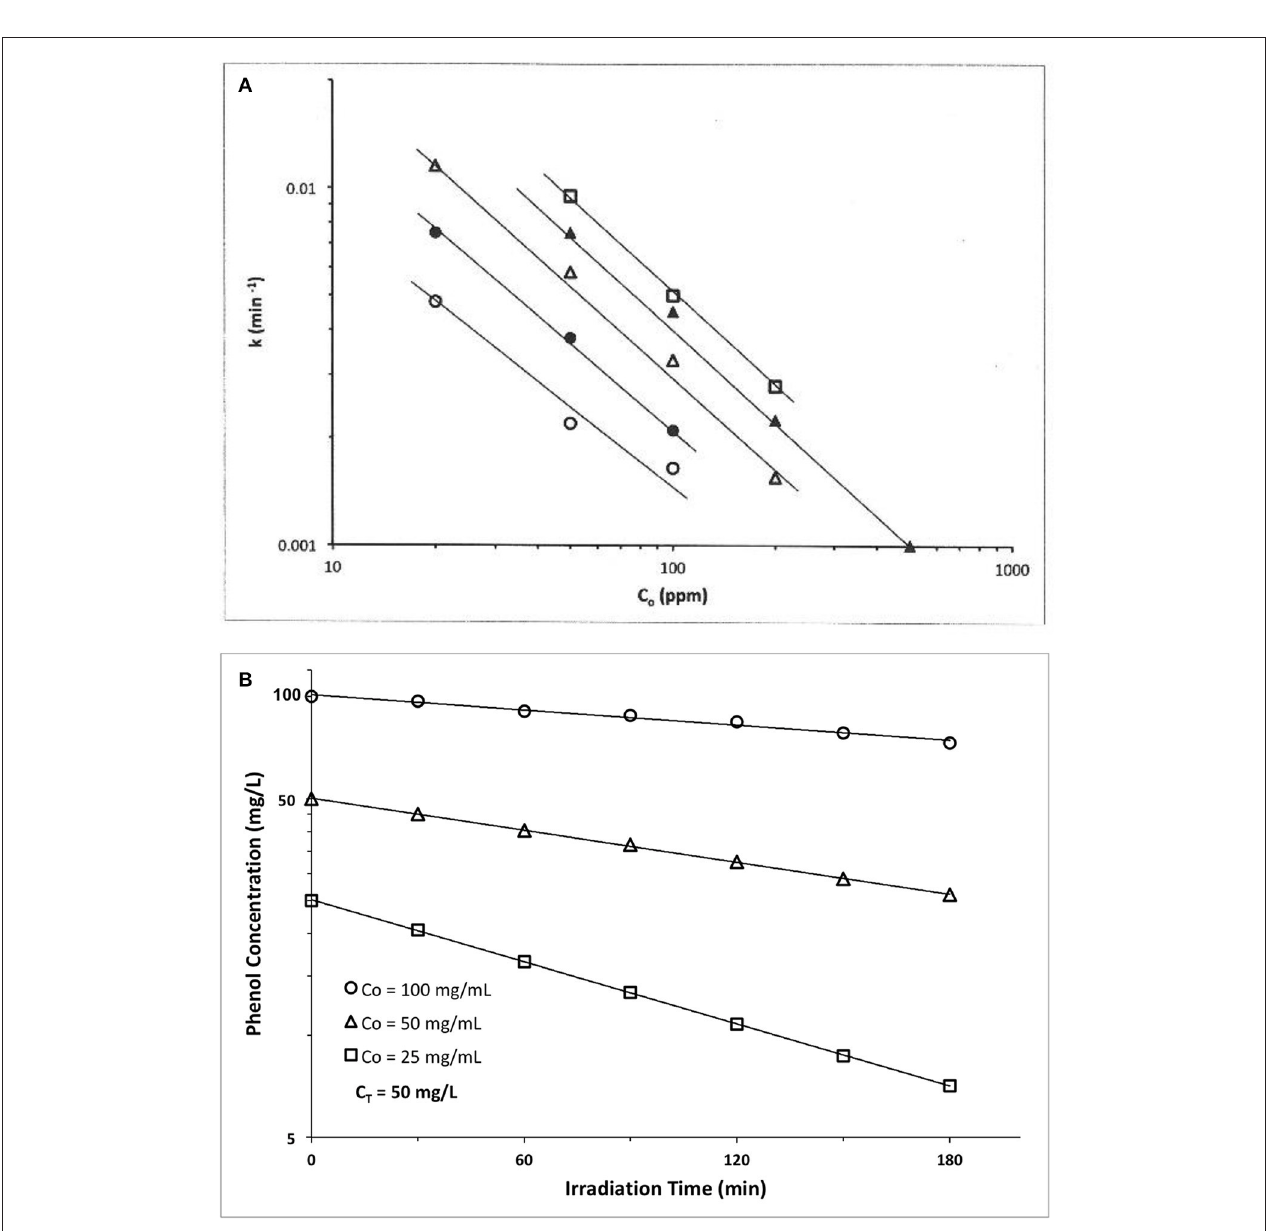
FIGURE 2 | (A) Photocatalyzed oxidation of phenol by illuminated ZnO. Semilog plots of apparent first order rate constants vs. initial solution concentration. All plots exhibit slopes of approximately − 1, confirming our claim that these data actually represent a zero order reaction, because the y-x product of apparent first order rate constant(y) times the initial concentration(x) is a constant, i.e., (yx) = k 1 C o = k o = zero order rate ((Kawaguchi, 1983); Reprinted with permission). (B) Photocatalyzed oxidation of phenol by illuminated TiO2(anatase). The product of apparent first order rate constant (slope) times the initial concentration, Co, is a constant, of average value 0.194mg phenol/l-min ( Table 1 ), thus indicating presence of a zero order reaction (Kawaguchi, 1984).